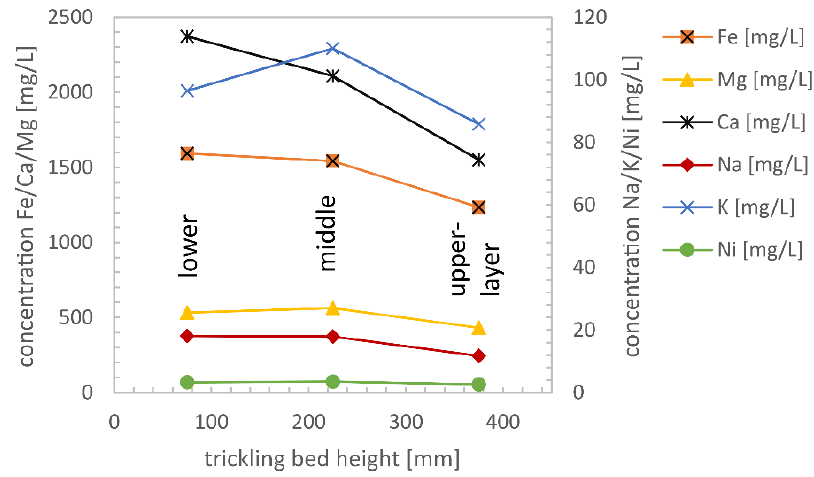
Figure 5. Element concentration in the biomass according to the sampling position (day 257).